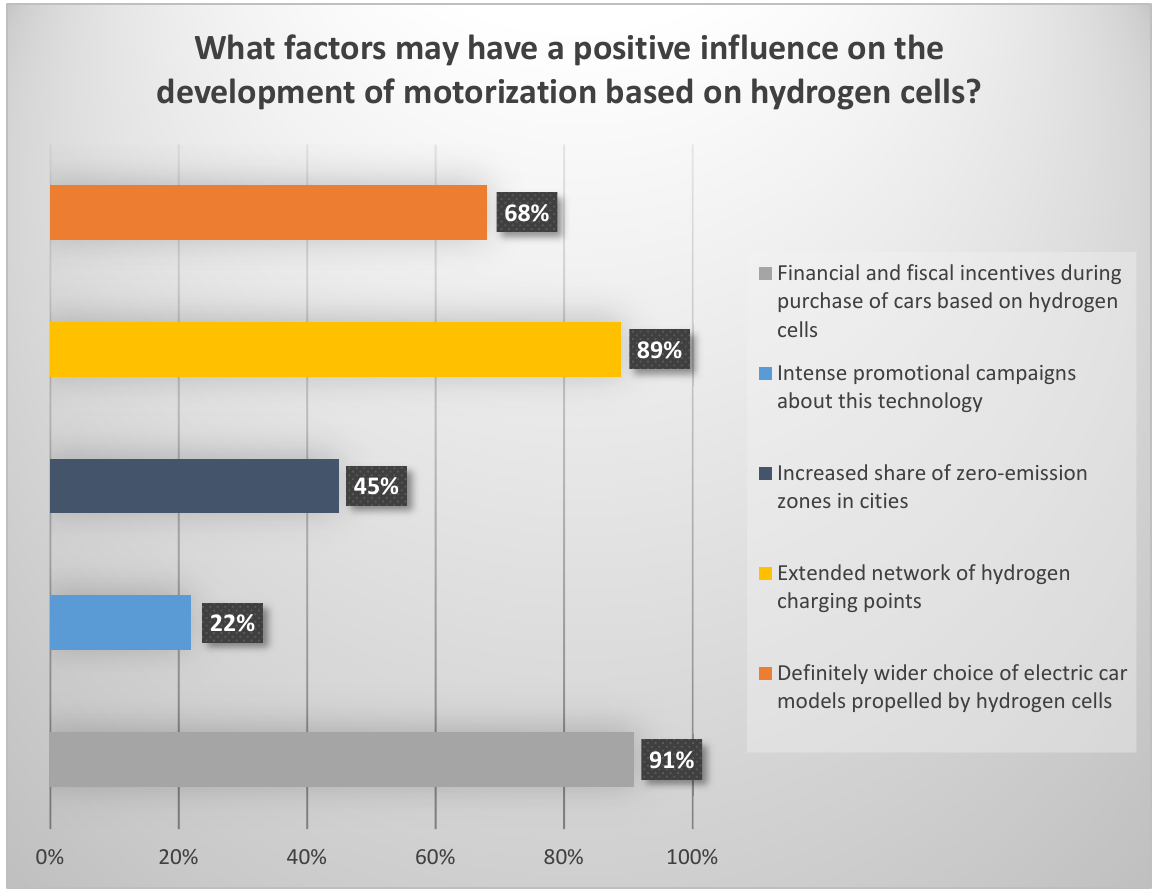
Figure 9. Survey question number 9. Source: own study.